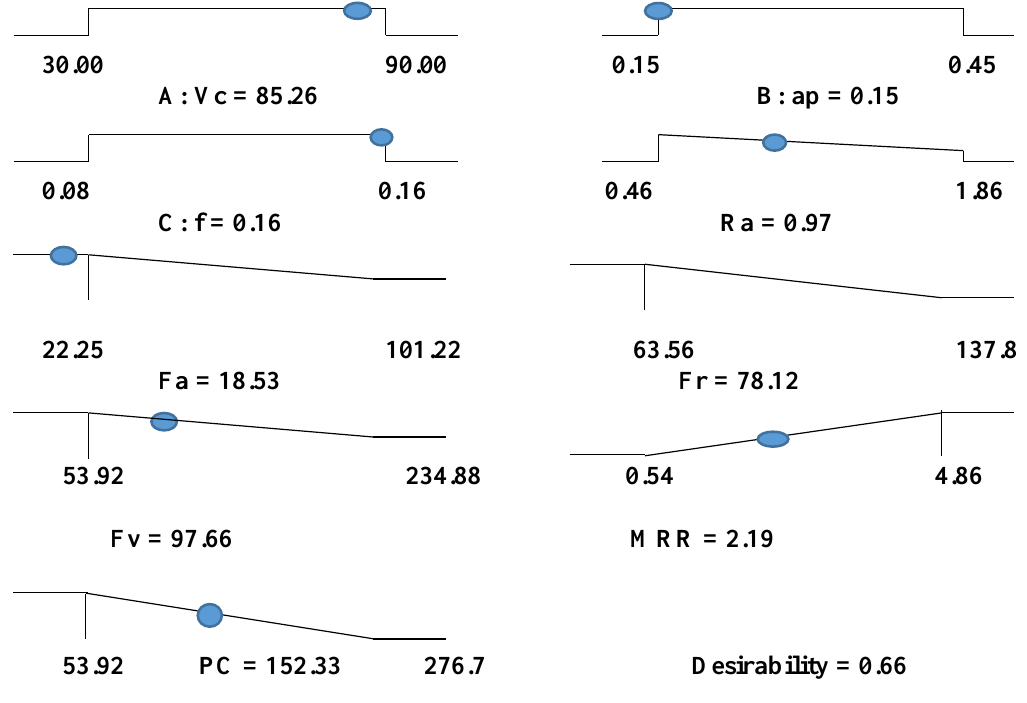
Fig. 20. Solution Ramps of multi-objective optimization for case (1)